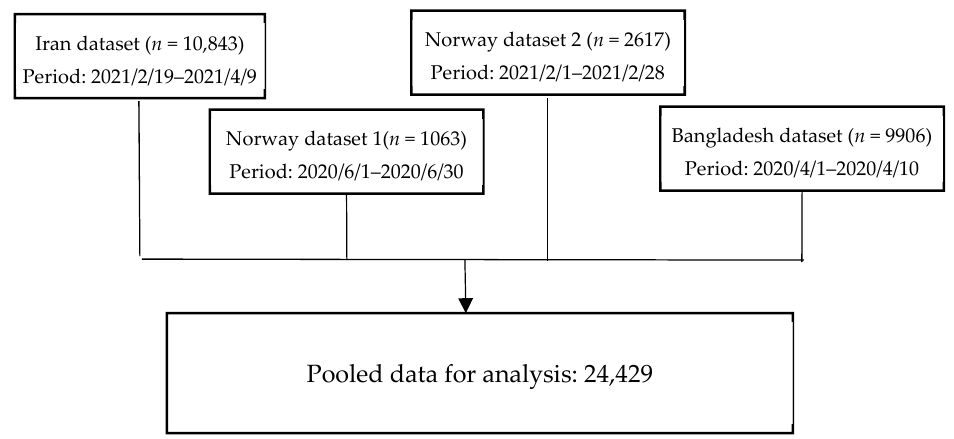
Figure 1. Data collection in four datasets.